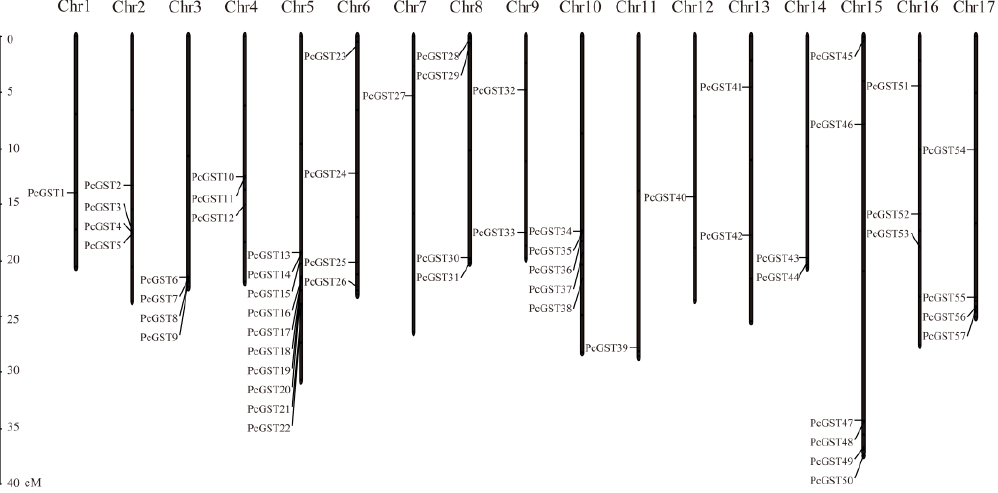
Figure 2. The chromosomal locations of PcGST genes in European pear. The position of PcGST genes was mapped to pear chromosomes based on the location information obtained from the genome of ‘Bartlett’